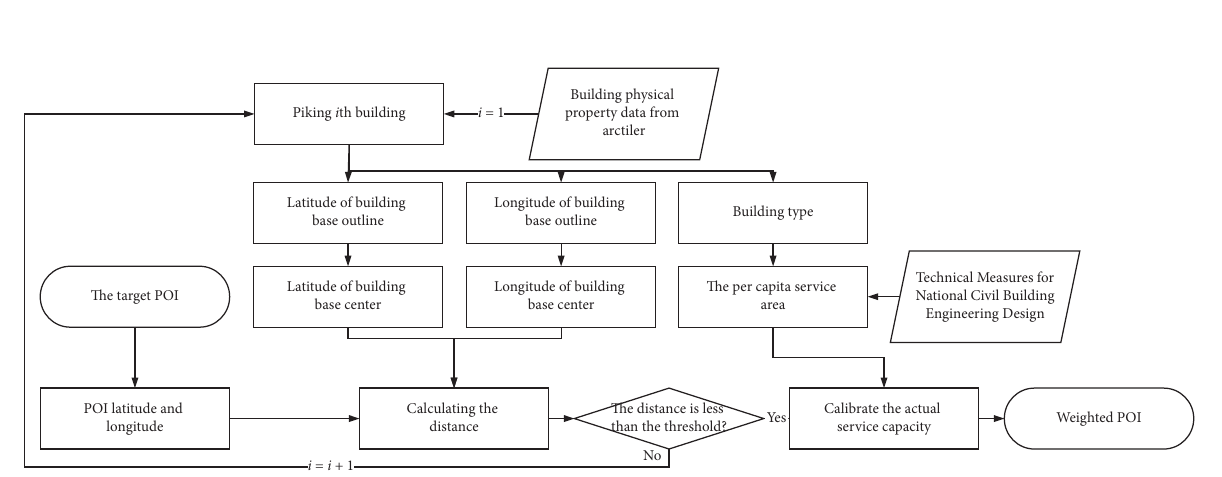
Figure 2: Fusion of multisource, geo-based data.